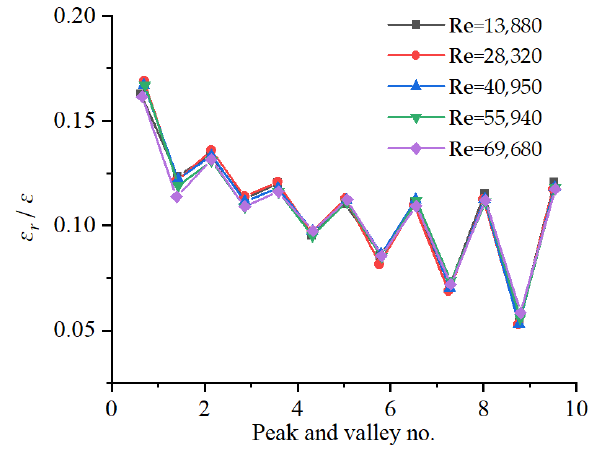
Figure 6. Ratio of retarded strain to total strain.